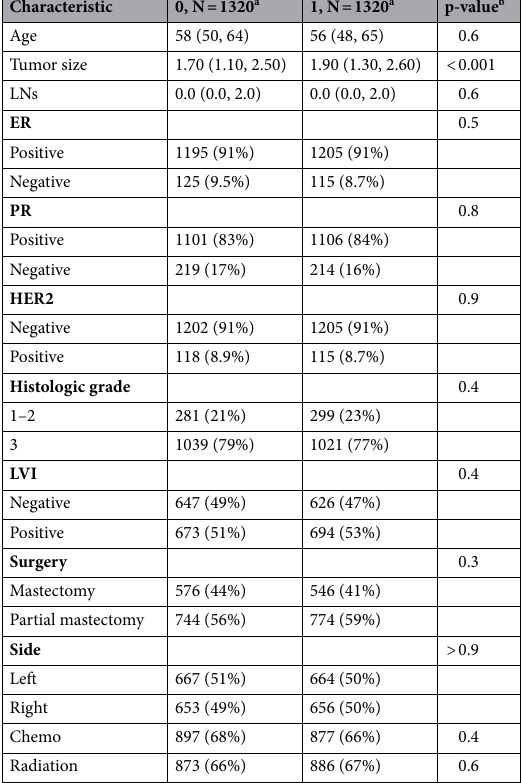
Table 4. Clinicopathologic characteristics of patients with PNI and matched PNI-negative controls. a Statistics presented: median (IQR); n (%). b Statistical tests performed: Wilcoxon rank-sum test; chi-square test of